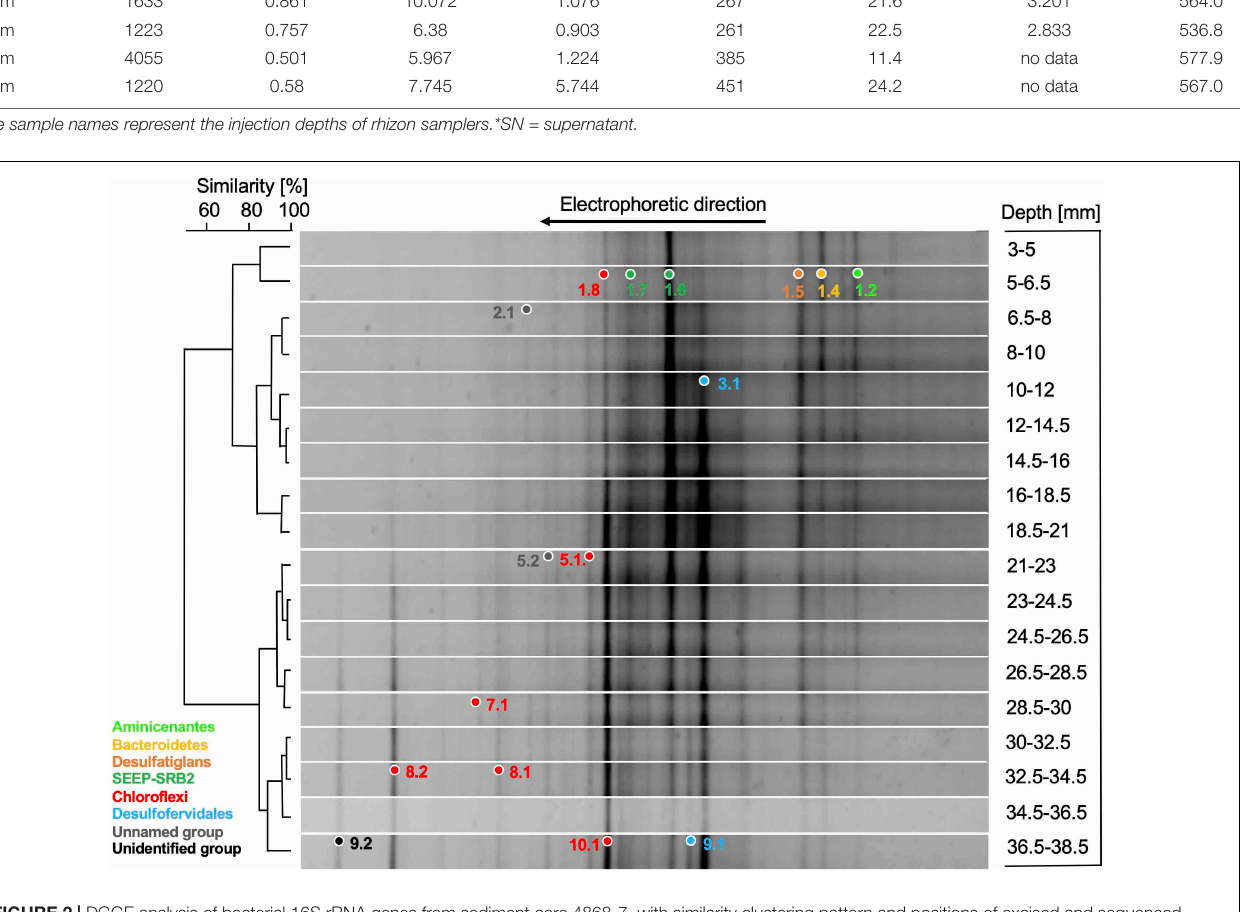
Frontiers in Microbiology |